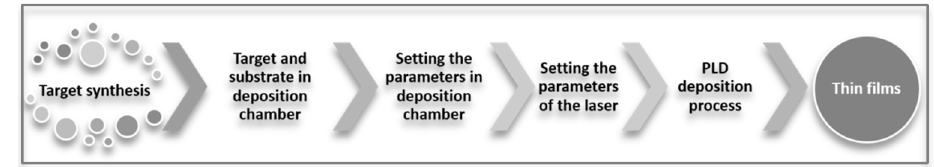
Figure 14. The scheme for the PLD deposition method.